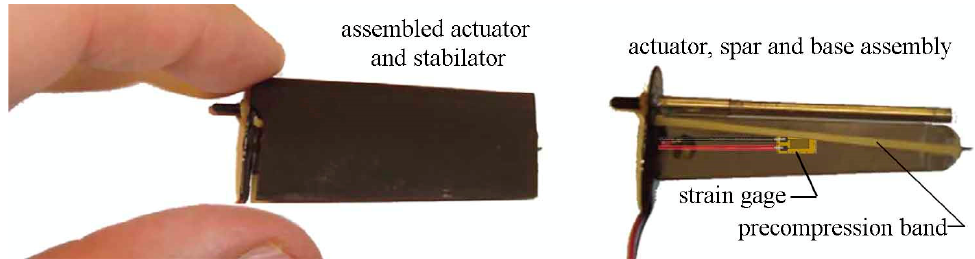
Figure 3. High-speed Flexspar actuator assembly in a micro flight control